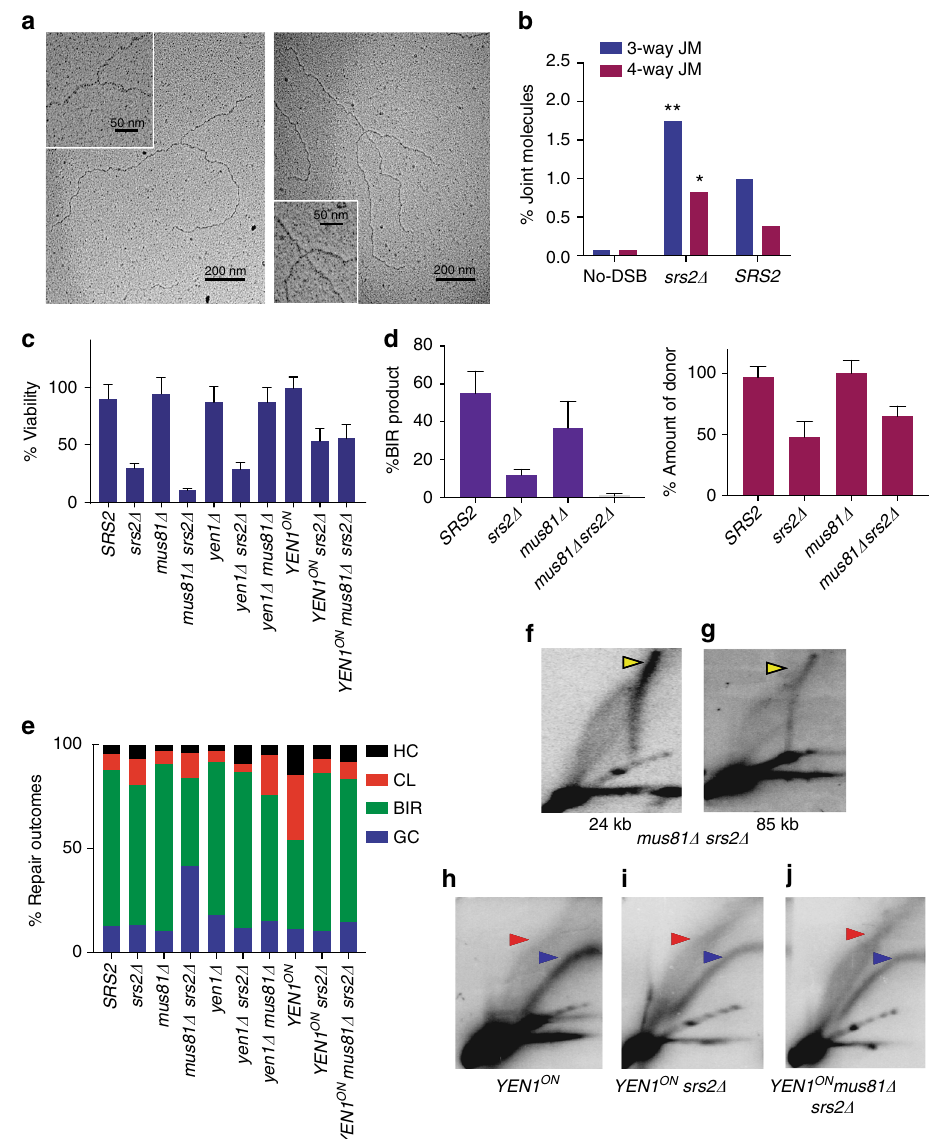
Fig. 2 Structure-speci fi c endonucleases resolve toxic BIR intermediates. a Representative images of DNA fragments containing 3-way and 4-way junctions (joint molecules, JMs) in srs2 Δ identi fi ed by EM analysis of genomic DNA isolated 7 h following induction of BIR. Scale bars correspond to 200 nm in the entire fi eld images and 50 nm in the enlarged images. b The fraction of DNA fragments containing 3-way and 4-way junctions in SRS2 , srs2 Δ and no-DSB srs2 Δ control. The ** and * indicate a statistically signi fi cant difference from SRS2 with P = 0.0066 and P = 0.0379, respectively. c Cell viability following BIR induction in cells containing various mutations, including srs2 Δ , mus81 Δ , yen1 Δ , and YEN1 ON . d Quanti fi cation of BIR product (left) and of the donor chromosome (right) at 8 h following initiation of BIR. e Distribution of DSB repair outcomes following BIR repair in various mutants shown in C. f and g 2D gel analysis of BIR intermediates in srs2 Δ mus81 Δ using probes speci fi c to 24 kb position and 85 kb position, respectively, away from the DSB site. h – j shows 2D intermediates detected by 24 kb probe in h YEN1 ON , i YEN1 ON srs2 Δ , j YEN1 ON mus81 Δ srs2 Δ . Yellow and blue arrowheads denote “ spike ” and bubble intermediates, respectively. Red arrowhead denotes ‘ rubble ’ intermediate. Quanti fi cation of cell viability, the amount of product formed, and amount of donor present was based on ≥ 3 independent experiments and presented as means with standard deviations